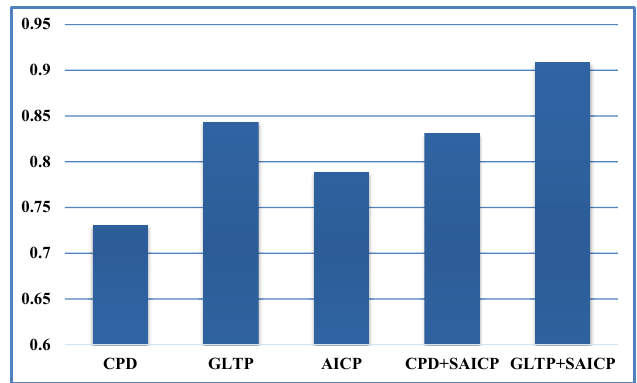
Figure 12. Result comparison on SCAPE data with the labeling accuracy of body